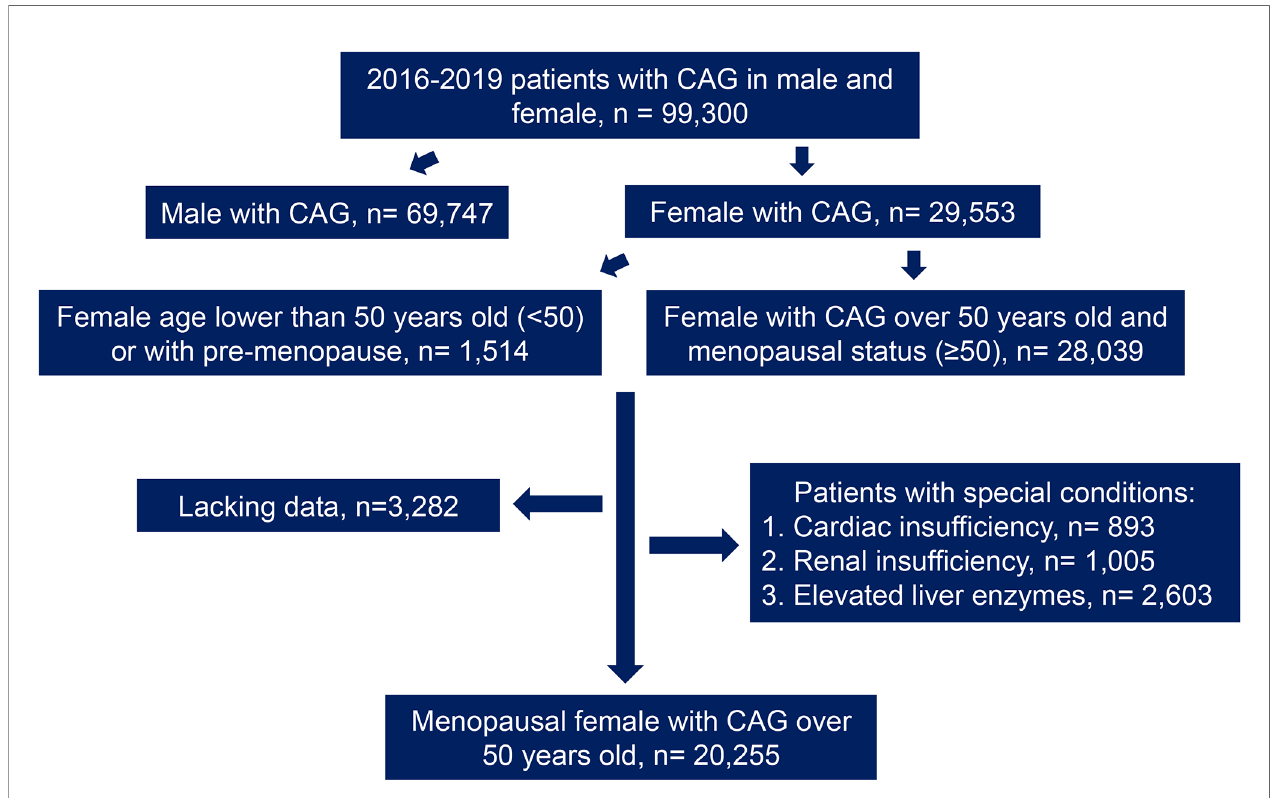
FIGURE 1 | Flow chart. CAG, coronary